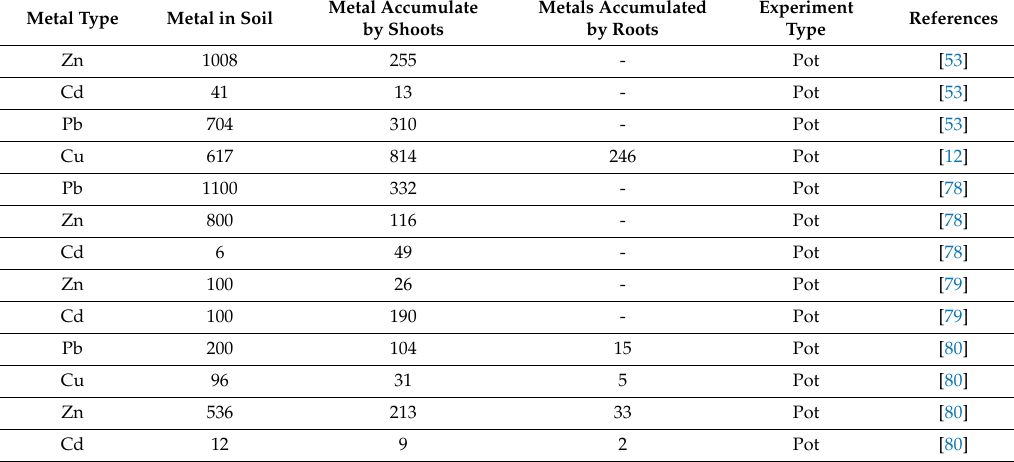
Table 2. The capacity of the flax plant to accumulate di ff erent heavy metals in the shoots (mg kg − 1 ) and roots (mg kg − 1 ) when grown in metal contaminated